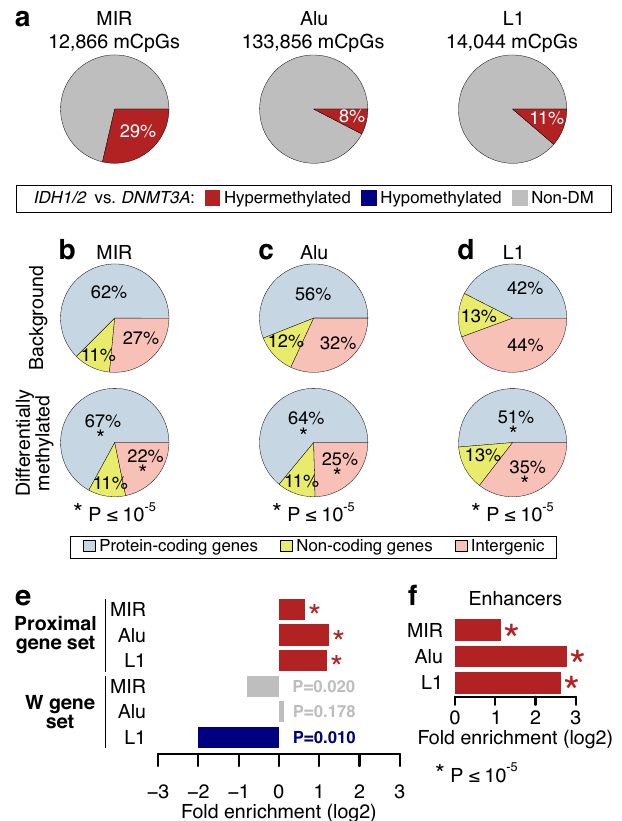
Fig. 4 | DNA methylation changes on MIR, Alu and L1 elements. a Pie charts showingthepercentageof differentiallymethylatedcytosines(DMCs)overlapping the respective elements. b – d Pie charts showing the enrichment of protein-coding genes around the DMCs with reference to all cytosines included in the analysis, statistically evaluated with chi-squared tests. e Fold enrichment of the proximal or WgenesetsoverlappingtheDMCsofeachrepetitiveelement. f Foldenrichmentin enhancers overlapping the DMCs of each repetitive element. For e , f , p values are noted on the fi gures, asterisks indicate enrichment or depletion with p value <10 − 5 per hypergeometric test (one-sided) for n =3685, n =10,162 and n =1585 DMCs overlapping MIR, Alu or L1 elements, respectively. Source data are provided as a Source Data fi